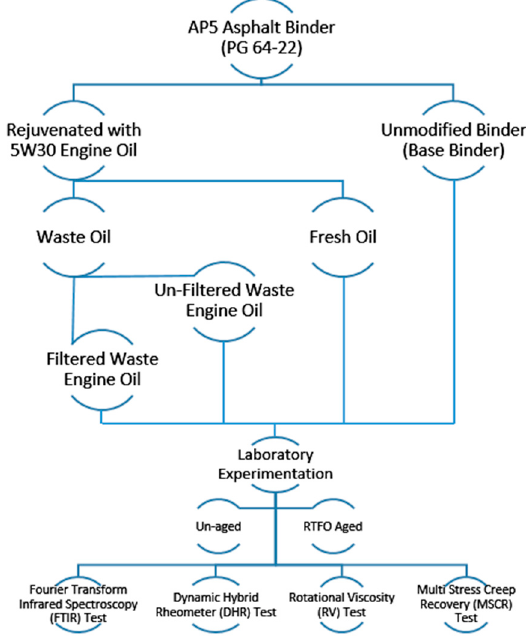
Figure 3. Procedural flow chart.